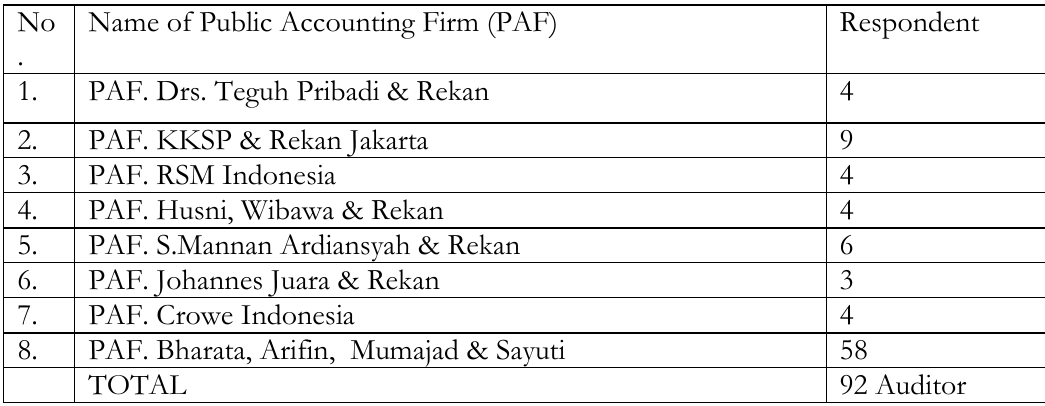
Table 1 Distribution of Questionnaires Based on Public Accounting